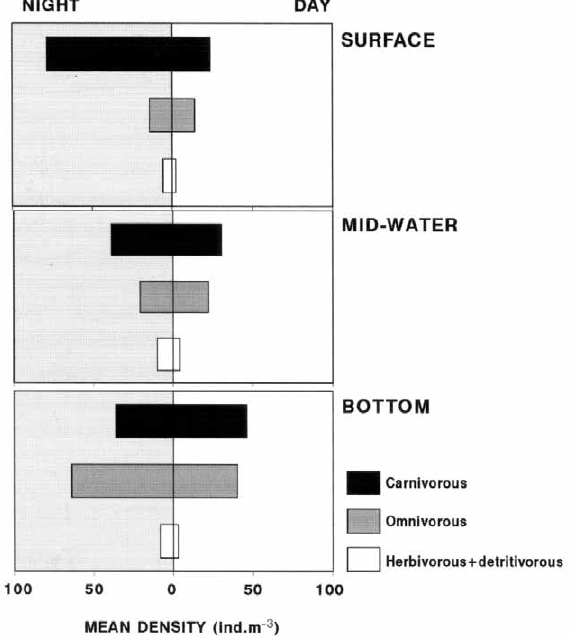
F IG . 5. – Mean density of the zooplankton trophic levels, at the three depths, in the day and night periods. Concentrations (ind. m -3 ) are represented by horizontal bars. Shaded area: night.